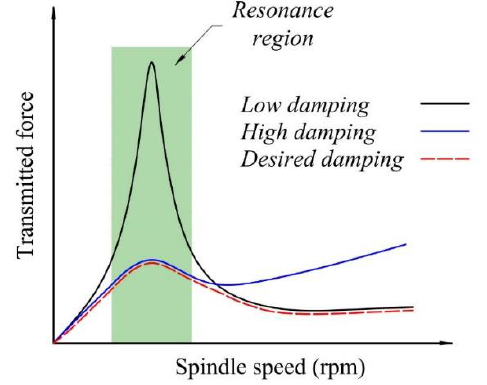
Figure 1. Force transmissibility of washing machines using different vibration control systems.